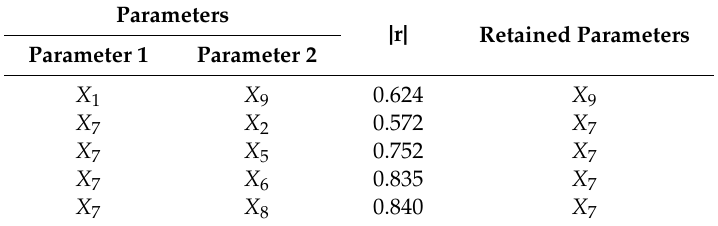
Table 8. Pearson coe ffi cients of process parameters of 5000 t / d production